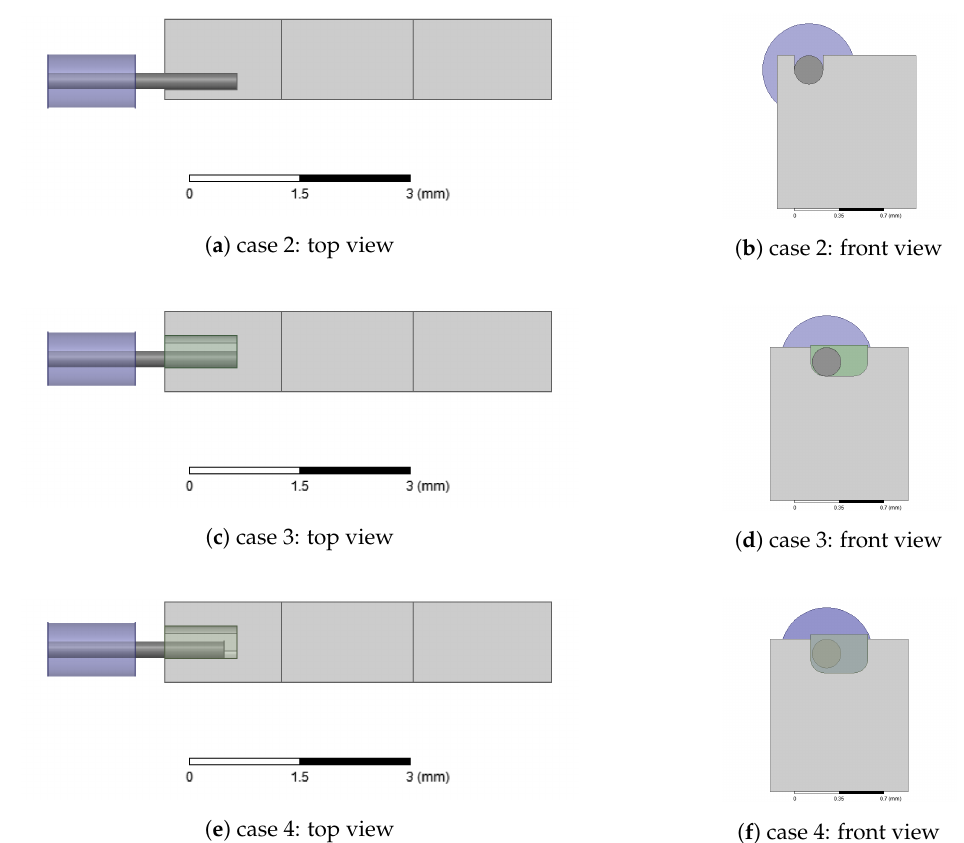
Figure 13. Geometry of the cases tested for the non perfect alignment of the end-launcher (gray) on the ridge (light gray), displayed in top and frontal view: ( a , b ) case 2, ( c , d ) case 3, ( e , f ) case 4. The glue which fills the groove is displayed in